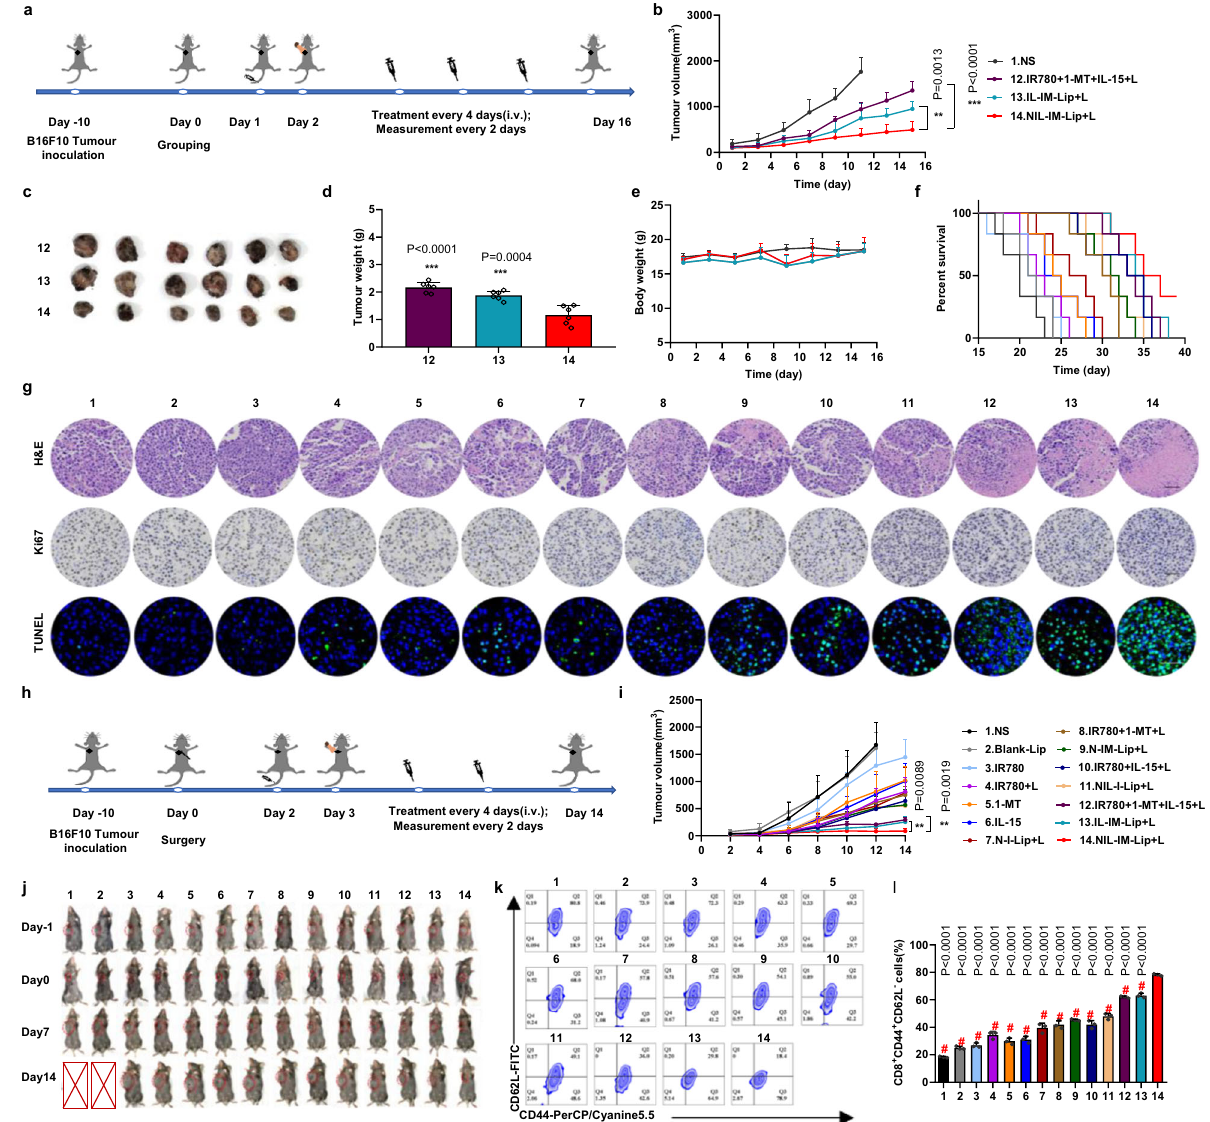
Fig.6|Theantitumourandpostsurgicalrecurrenceef fi cacyofNIL-IM-Lip+Lin theB16F10primaryandpostsurgicalrecurrencemodels. Mice wereeuthanized when the tumour volumes reached ~2000mm 3 . a Schedule of the antitumour experiment in B16F10 tumour-bearing C57BL/6 mice. b Tumour volume curves of NS, IR780+1-MT+IL-15+L, IL-IM-Lip, and NIL-IM-Lip+L treated B16F10 tumour- bearing C57BL/6 mice ( n = 6 biologically independent animals per group).